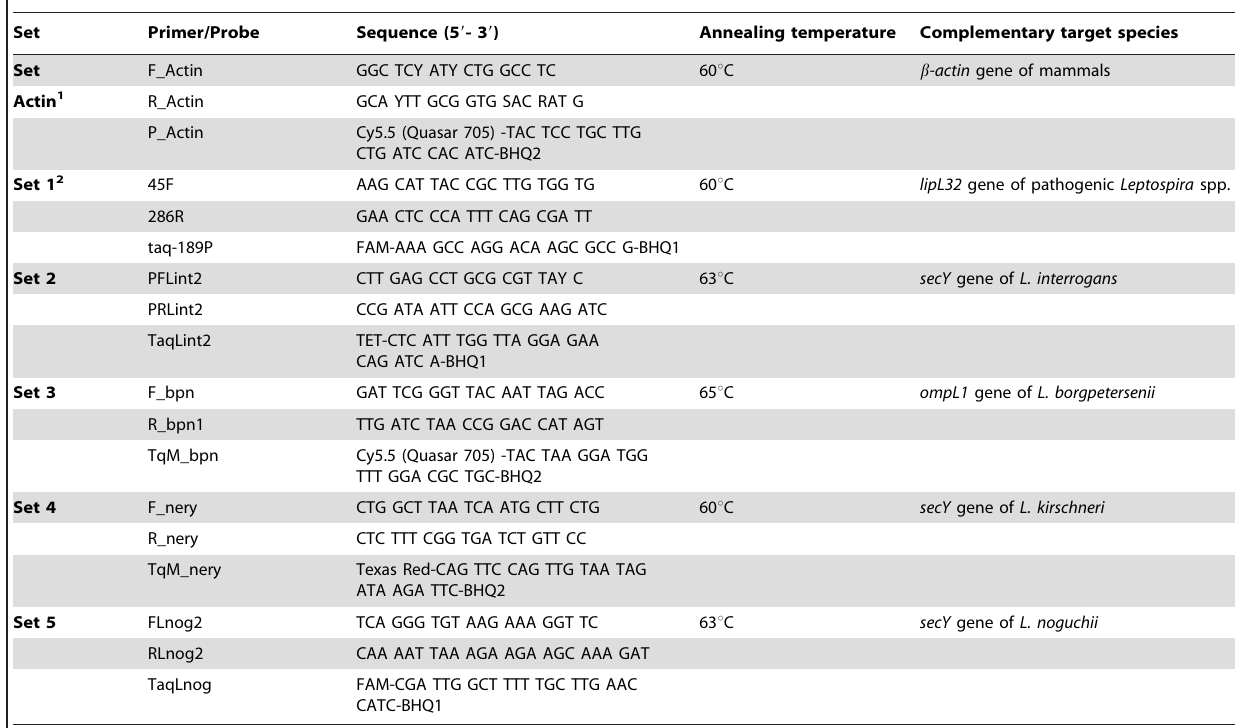
Table 3. Primers and probes used in this study targeting selected genes of pathogenic species of Leptospira .